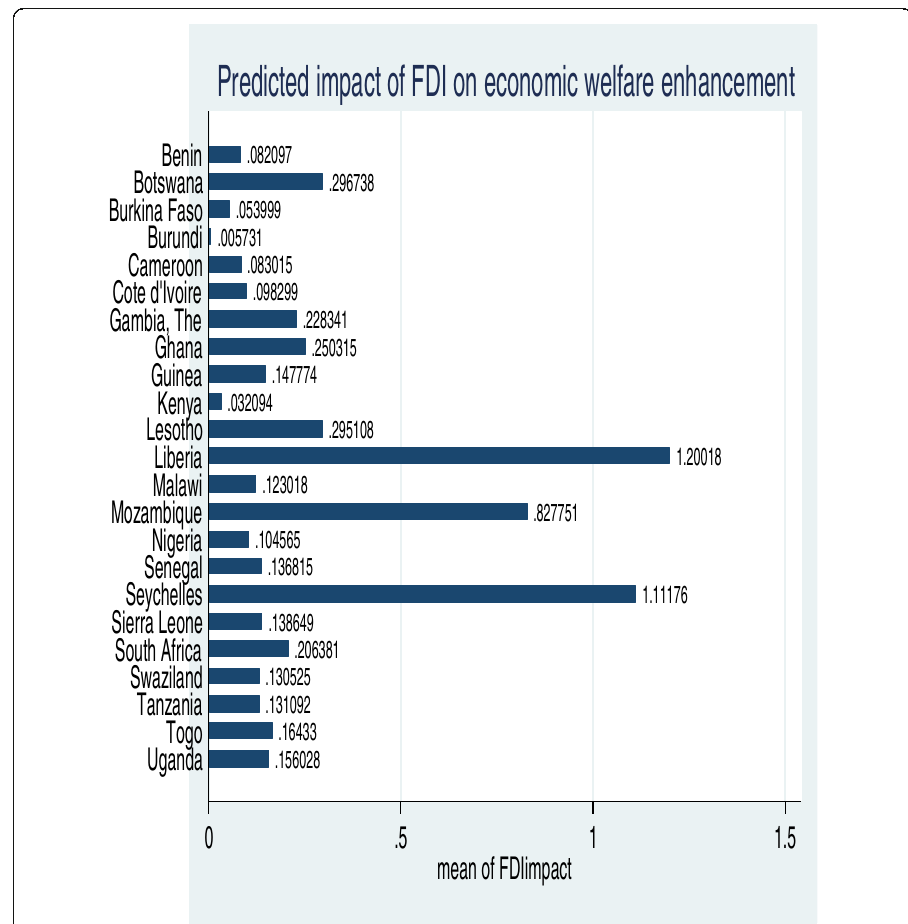
Fig. 1 Predicted (mean) impact of FDI on economic welfare at different levels of financial development (Domestic credit as proxy for financial